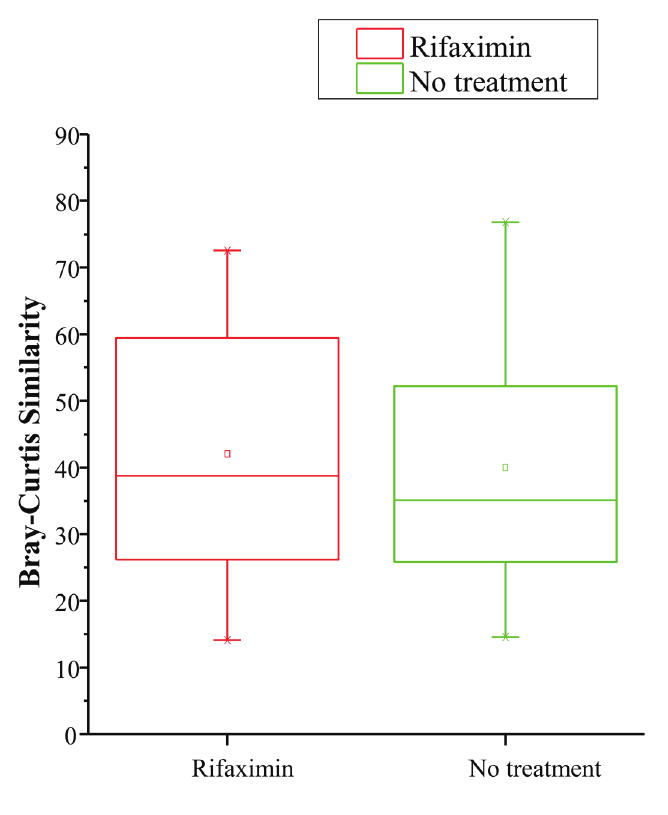
Supplementary Figure 1. Distribution of Bray-Curtis similarity values for patients with HIV+ in either no treatment or Rifaximin-treatment arms. Shown is the distribution of Bray-Curtis similarity values for each individual from visit 1 to visit 2. Mann-Whitney test indicates that at the 0.05 level, the two arms are NOT significantly different. Bray-Curtis similarity values are based on untransformed, but standardized, taxon abundance data at the level of